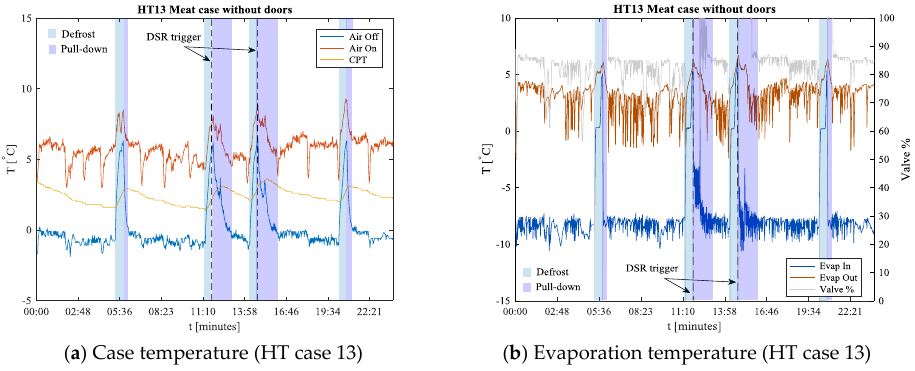
Figure 8. Evaporation temperature increase; air off and air on temperature is smoothed by the effect of thermal inertia. Case 13 is recovering from defrosts after triggered DSR events but the pull-down time is extended.